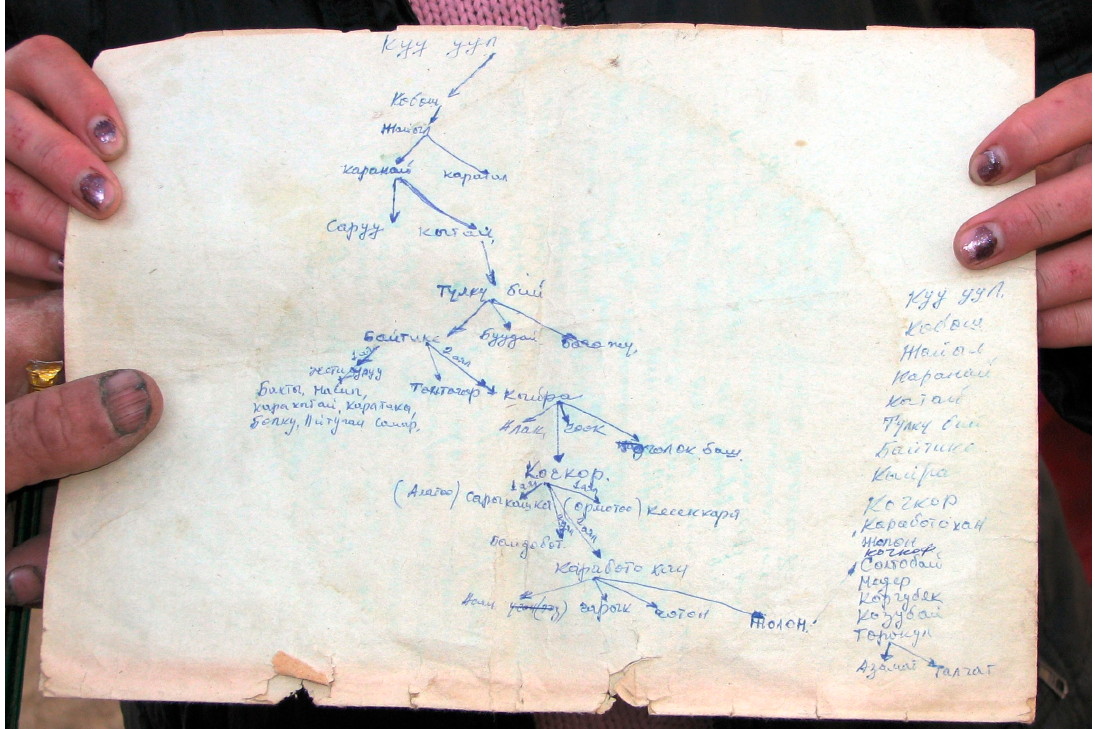
Figure 4. A Kara Buura carpenter’s sanjïra chart and extended jeti ata descent list from the Kuu uul branch of the Kyrgyz to himself in 18 generations. Saruu is given as a brother of Kïtay in the fifth generation from Kuu uul, rather than being a son of Kuu uul as in Figure 1. In addition, small notations (1 ayal , 2 ayal ) under Baytike in the seventh generation and Kochkor in the ninth generation indicates which son was born to which wife. Given names are provided in parentheses for two of Kochkor’s sons, whose descendants are known by their nicknames (Sarykashka, Kesek Kara). One of the Jeti Uruu listed here in the middle left is different than in Figure 3, but matches those in Figure 5.